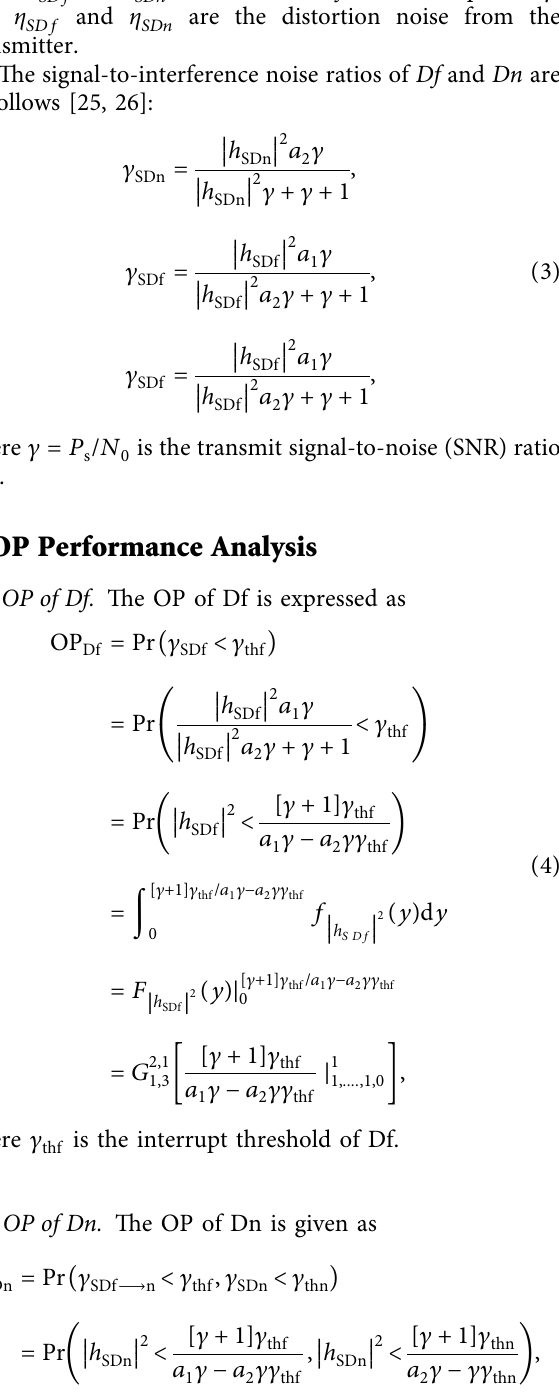
is a Nakagami variable. t